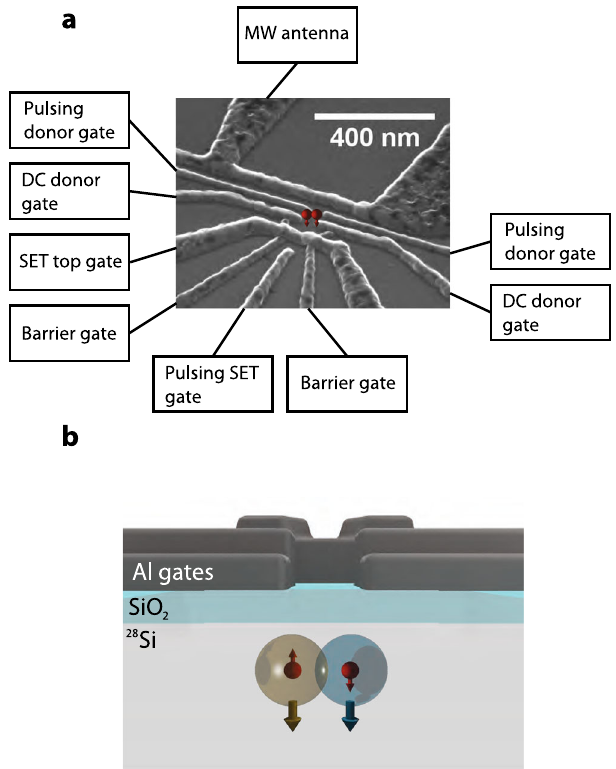
Fig. 1 Two-qubit metal-oxide-semiconductor device. a Scanning electron micrograph of a device similar to the one used in the experiment, with labels describing the function of the aluminum gates on the surface. b Schematic cross section of the device, depicting a pair of donors ≈ 10 nm beneath a thin SiO 2 dielectric, inside an isotopically enriched 28 Si